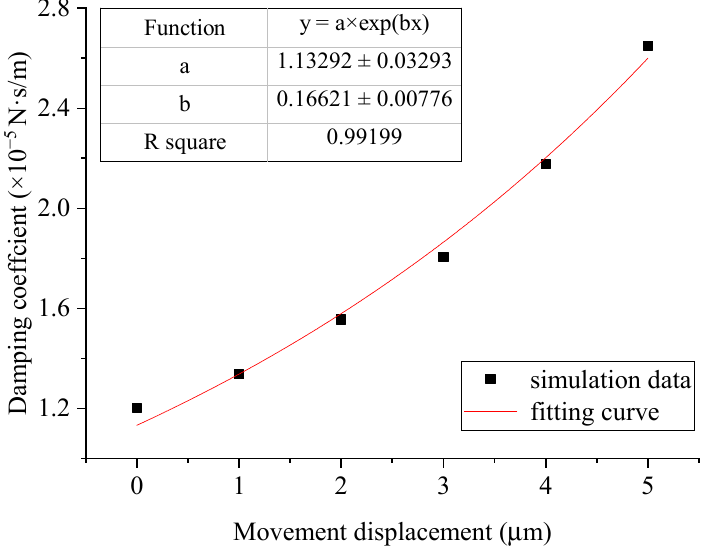
Figure 10. Variation in comb tooth damping with movement displacement and its fitting curve.